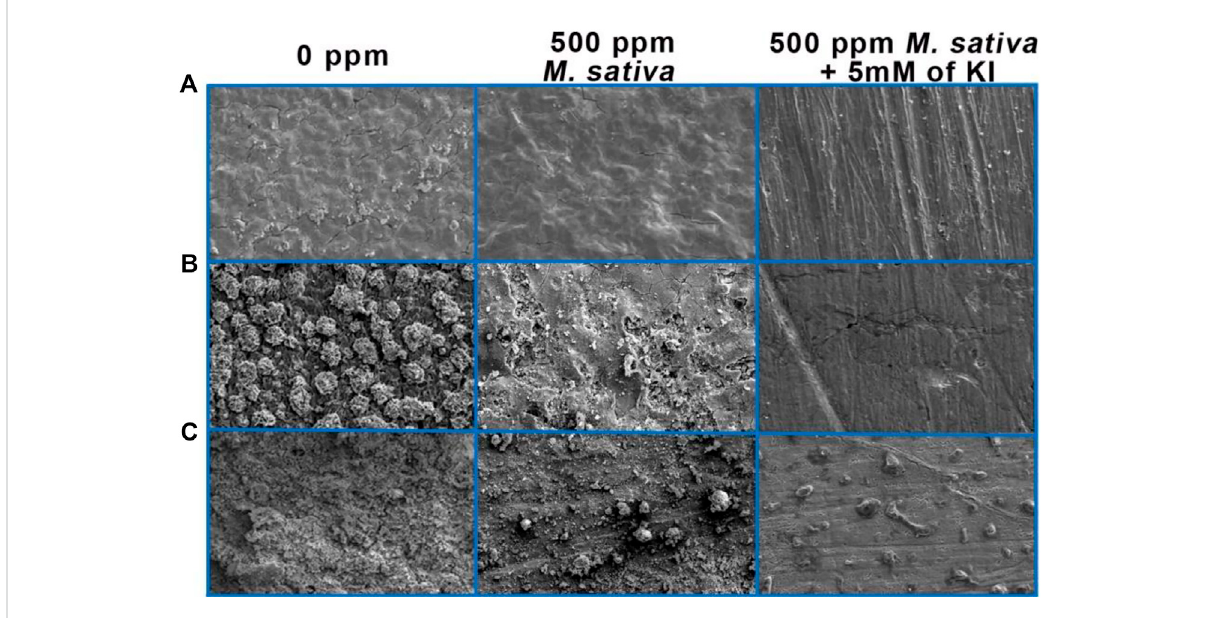
FIGURE 13 Micrographs of1018steelafterexposuretoacidmediawithandwithout500 ppm M.sativa and5 mMofKIatdifferenttemperatures. (A) 25 ° C± 2 ° C, (B) 40 ° C, and (C) 60 °